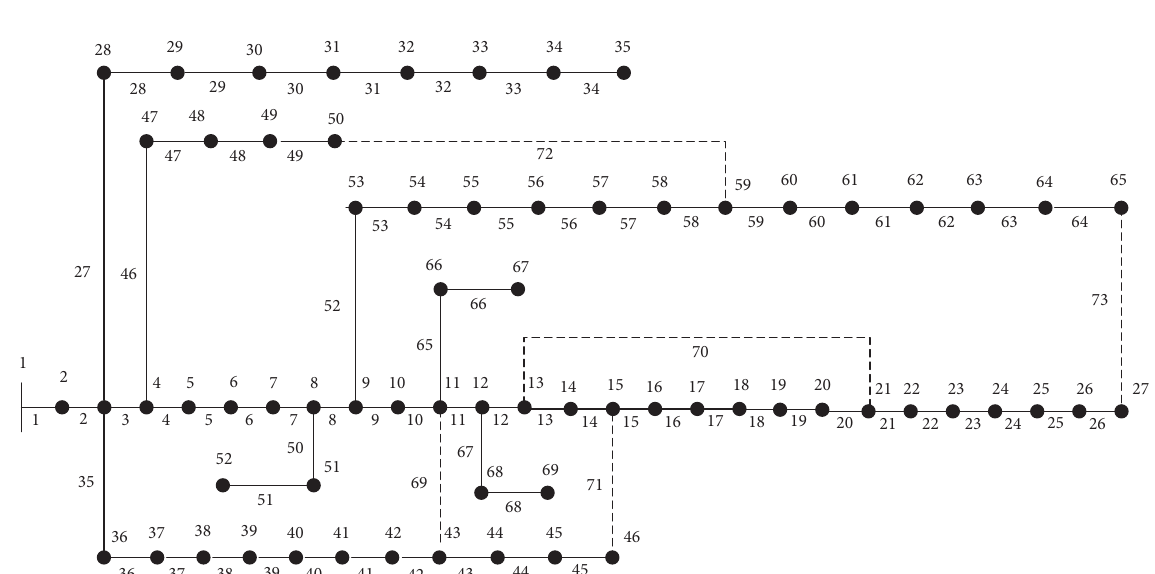
Figure 10: The 69-node test